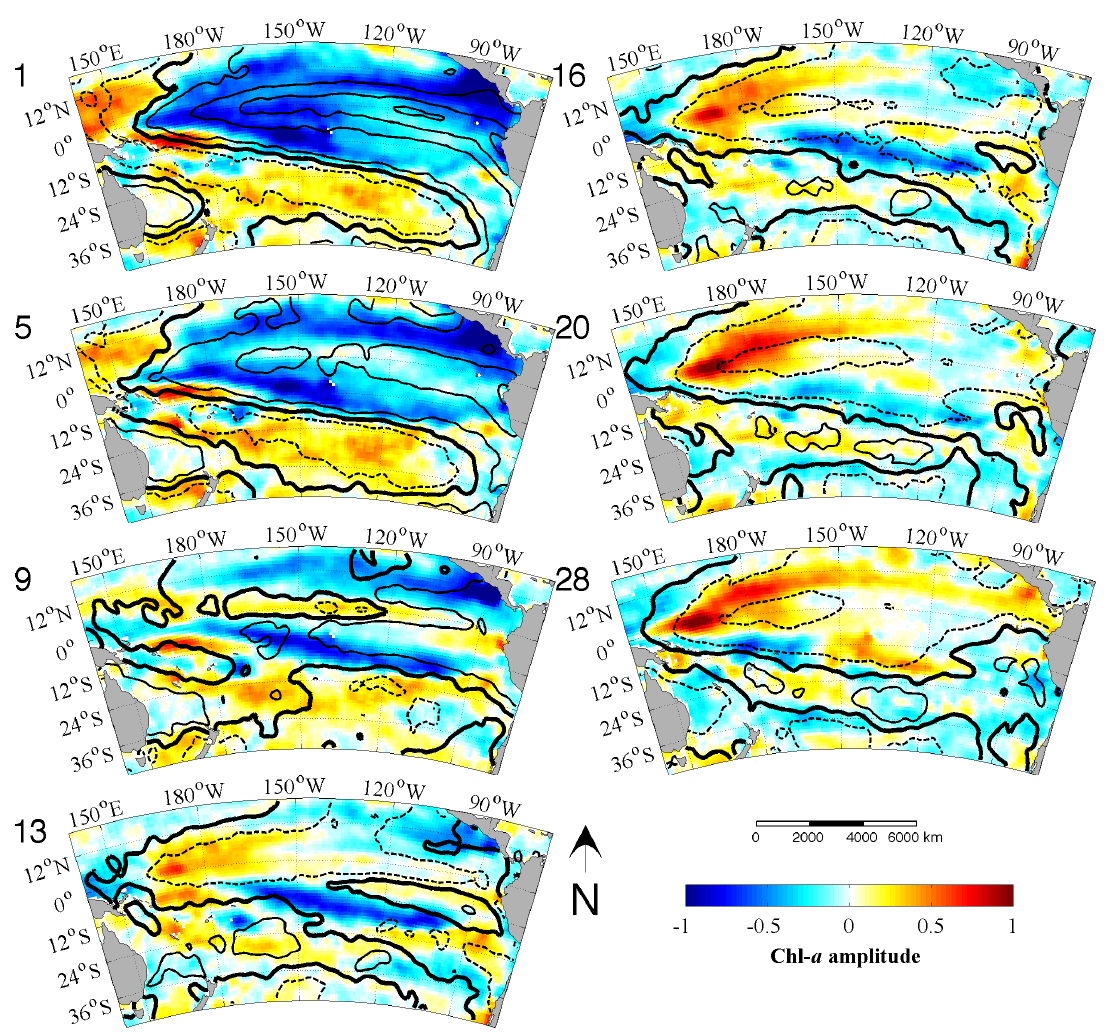
Figure 7. Chl -a A amplitudes from extended empirical orthogonal function (EEOF)-2 (L = 28) spatial lag-sequence overlaid with projected SSTA contours in steps of 3. Units are non-dimensional [18]. Positive sea surface temperature anomaly values are solid and negative values are dashed, while the zero line is bold. Months displayed are 1, 5, 9, 13, 16, 20 and 28, respectively. Panels are plotted on a Lambert